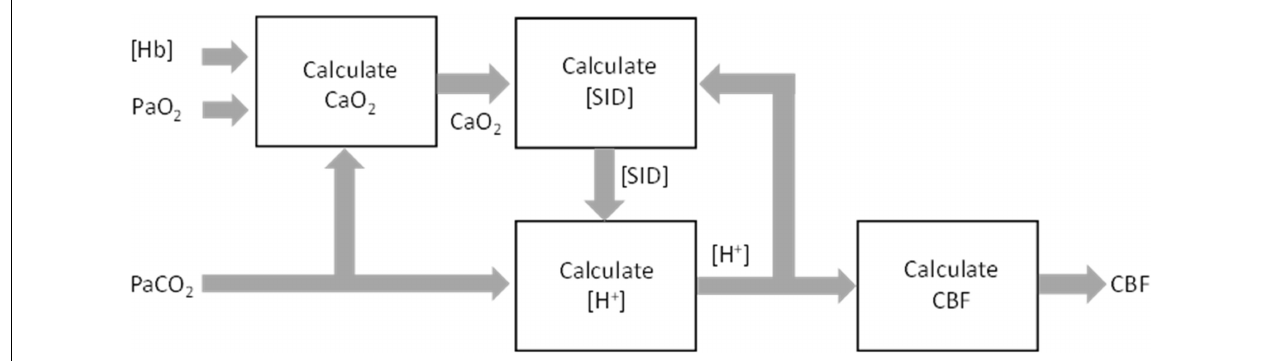
FIGURE 5 | Implementation block diagram of the feedback control of cerebral blood flow (CBF) by PaCO 2 , PaO 2 , and [Hb].